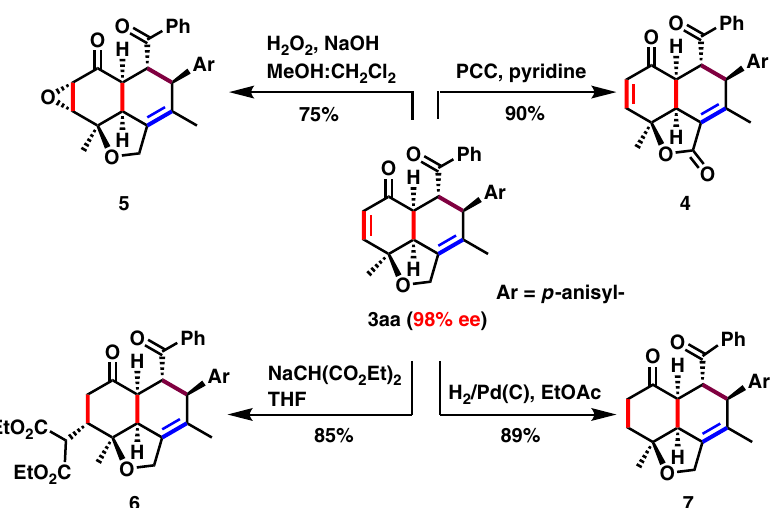
Fig. 4 Synthetic Transformation of 3aa . Isolated yields are given and enantioselectivity was determined by SFC equipped with a chiral stationary phase